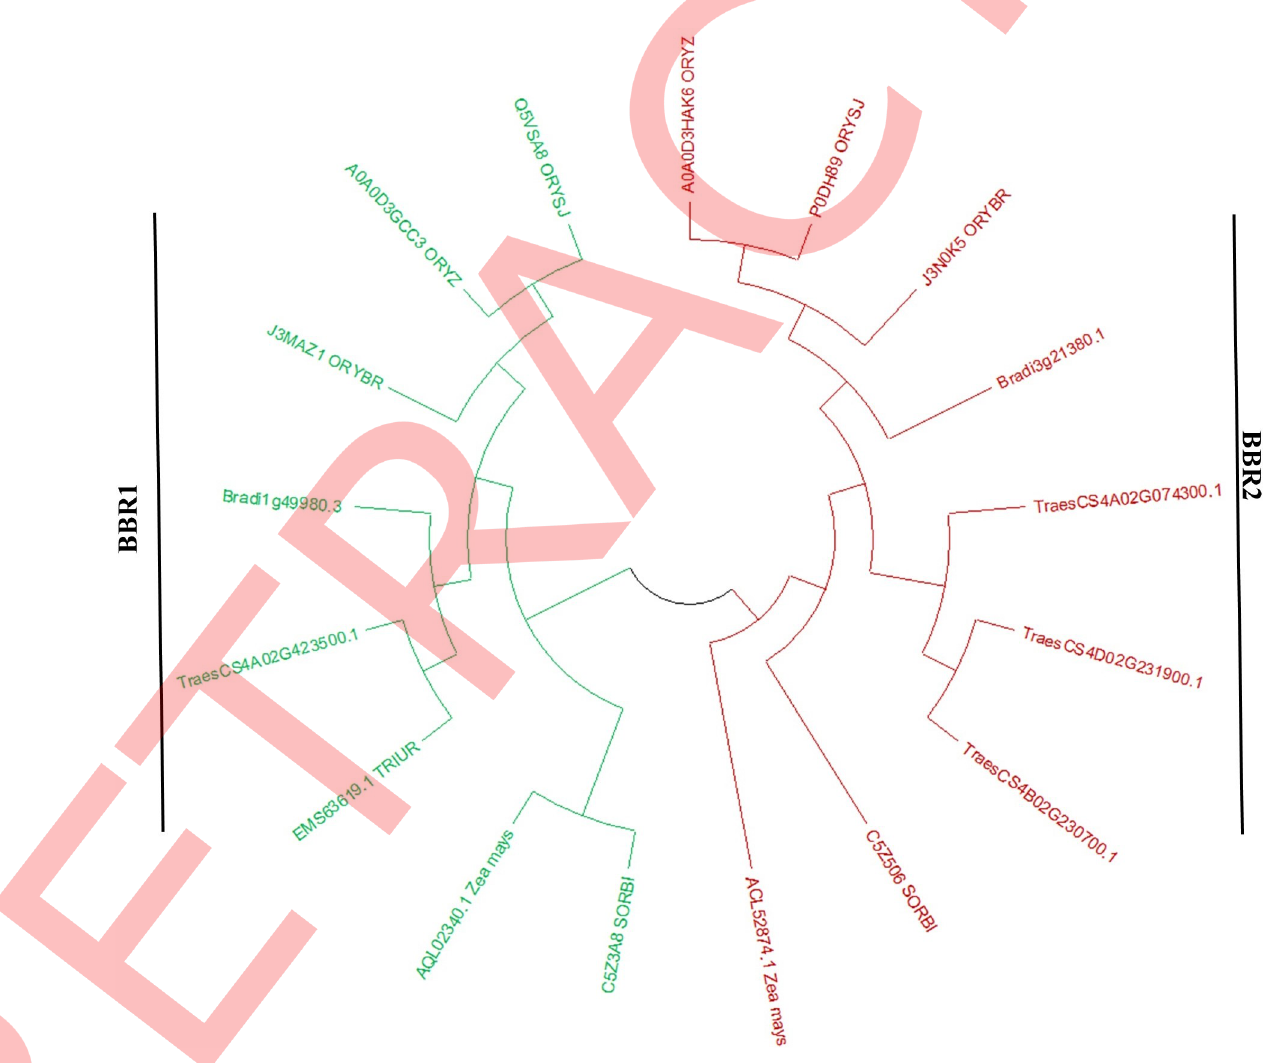
Fig 2. Phylogenetic analysis using the Maximum Likelihood method. The tree with the superior log likelihood (-4765.88) is shown. The analysis of BBR involved 17 amino acid sequences. There was a total of 479 positions in the final dataset.